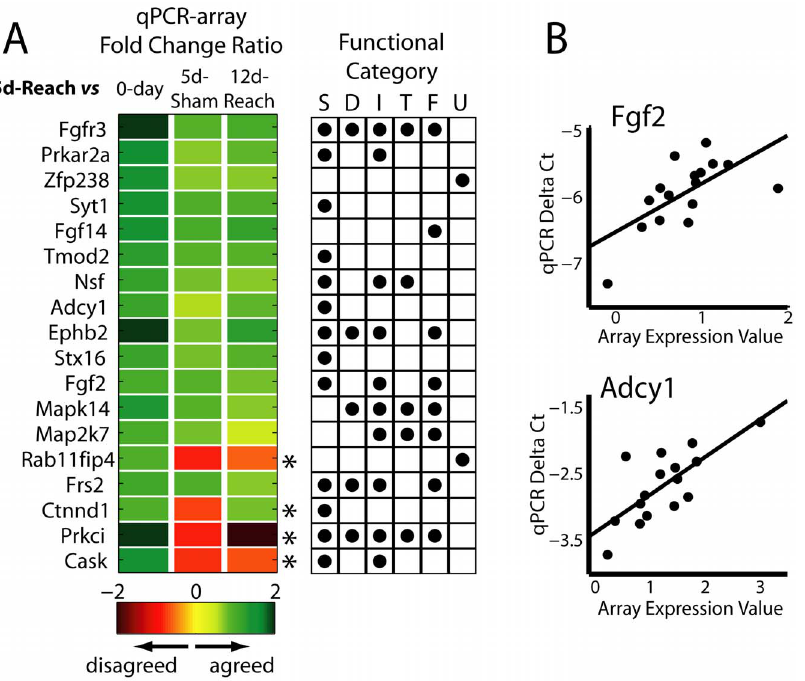
Figure 10. Microarray data were validated using qPCR. A , Gene expression fold changes indicated by microarray and qPCR. Eighteen genes (listed on the figure’s left) were selected from the synapse, FGF, and unclustered categories for qPCR validation. Array and qPCR fold change values were calculated for each gene for the comparisons, 5-day-Reach versus 0-day, 5-day-Reach versus 5-day-Sham , and 5-day-Reach versus 12-day-Reach , resulting into a total of 18 6 3=54 comparisons. The extent of agreement between the direction of fold change values derived from the two methods was assessed by the ratio of qPCR-fold change to the array-fold change. A positive ratio indicates an agreement, and a negative ratio, a disagreement. The heat map on the left shows this ratio of each of the 54 comparisons using a color map with green showing the highest (positive) value, and red, the lowest (negative) value. Four genes ( Prkci , Rab11fip4 , Ctnnd1 , and Cask ) showed a disagreement in at least one of the three comparisons. These four genes showing mismatches between the array- and qPCR-fold change directions (*) were also the ones whose qPCR- n C T values of the 5-day- Reach group were not significantly different from those of the other groups (p . 0.05), and whose qPCR- n C T values did not correlate well with the microarray expression intensities (p . 0.05). To the right of the heat map is a table indicating to which functional categories each gene belonged (S, synapse; D, development; I, intracellular signaling; T, transforming growth factor b receptor activity; F, fibroblast growth factor family; U, unclustered). B , For some of the genes, we observed an excellent correlation between the sample qPCR n C T values and the sample microarray gene expression intensities. They included Fgf2 (top panel; r =0.64. p , 0.01) and Adcy1 (bottom panel; r =0.73, p , 0.01). In both graphs here, the qPCR C T values were normalized with respect to those of the Ywhaz